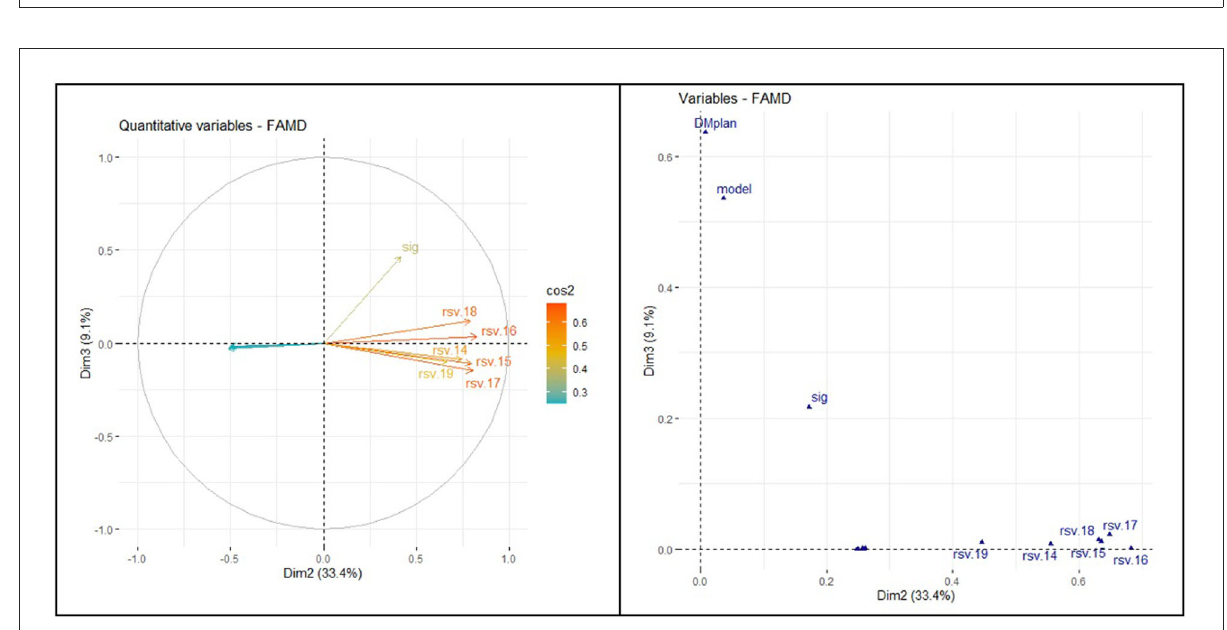
FIGURE7 Relationship between quantitative and qualitative variables (dimensions 2 and 3).